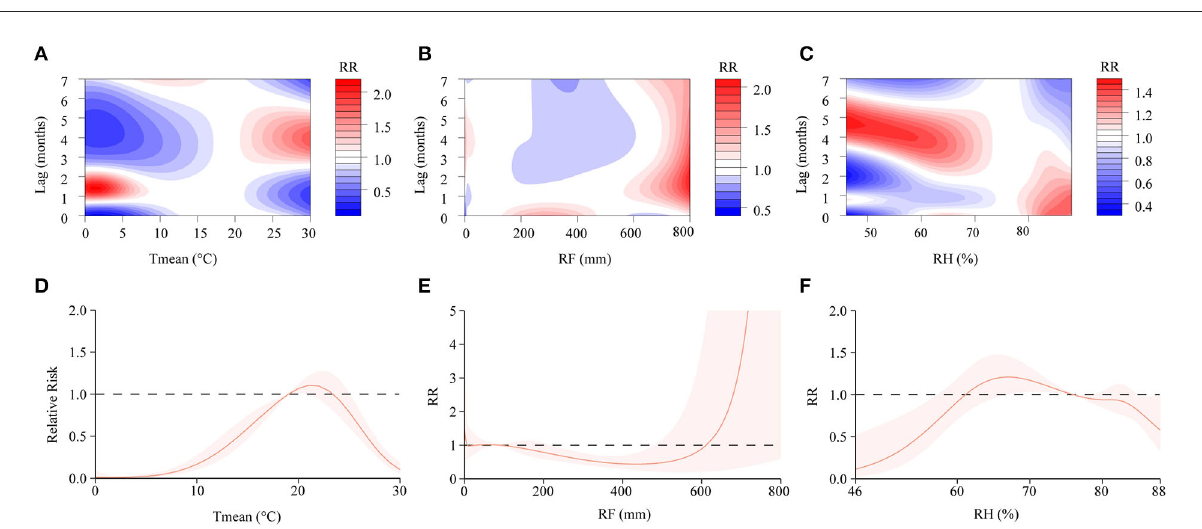
FIGURE6 Contour plots and cumulative exposure-response curves of exposure-response relationships between scrub typhus incidence and three meteorological conditions in the single-variable model. (A–C) The y-axis represents the lag period from 0 to 7 months. The x-axis represents the range of observations for each variable. The color gradient represents relative risk (RR). Red represents RR > 1, blue represents RR < 1, and white represents no difference when RR = 1. (D–F) The y-axis represents the RR. The x-axis represents the range of observations for each variable. Mean temperature (Tmean), rainfall (RF), and relative humidity